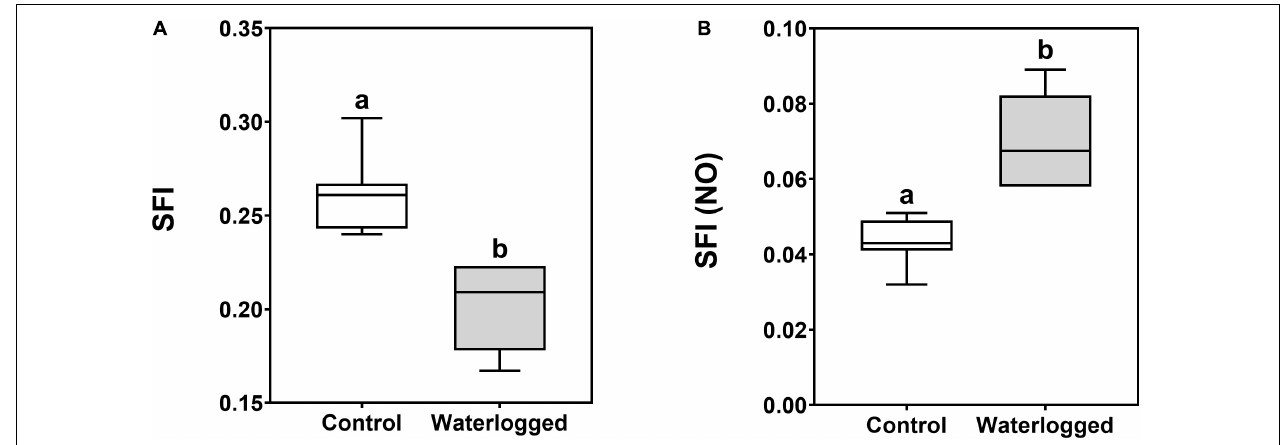
FIGURE 6 | Boxplots of the structure functional indexes for photosynthesis ( A , SFI) and non-photosynthetic or dissipation processes [ B , SFI (NO)] in leaves of control plants (white boxes) and waterlogged plants (gray boxes) of Spartina patens after 30 days ( n = 10, different letters indicate significant differences at p < 0.05).